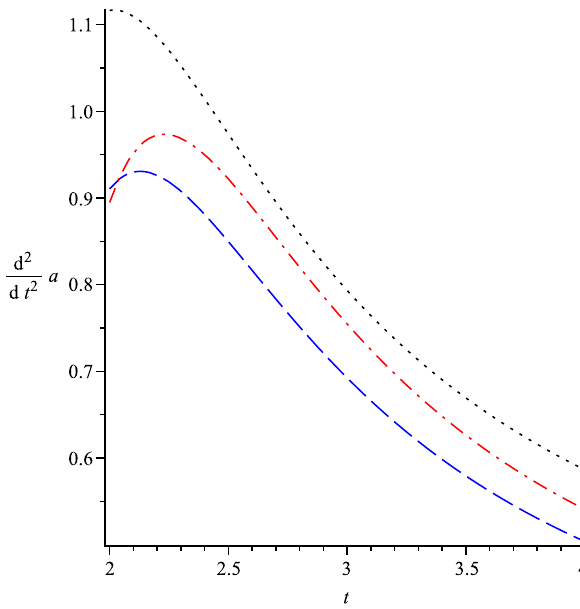
Fig. 3 Represents the variation of acceleration parameter vs t for γ =